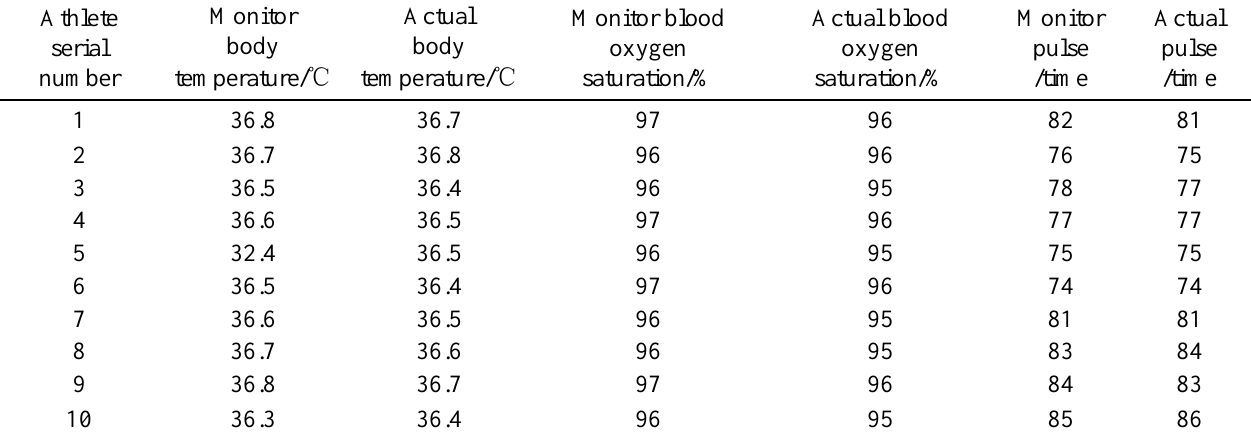
Table 2. Feedback on the effect of remote consultation